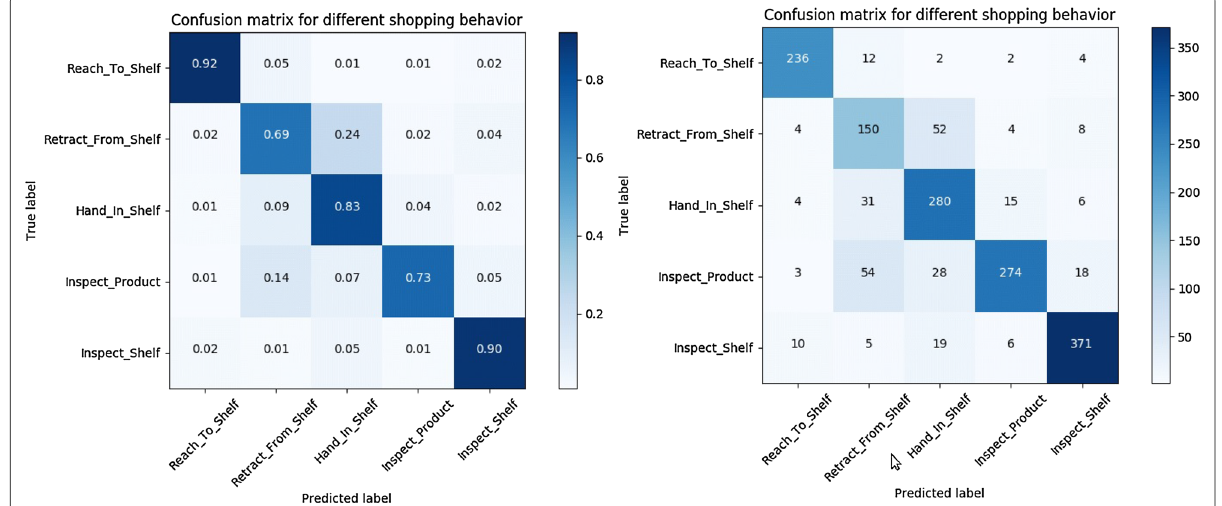
Fig. 10 Confusion matrix of different shopping